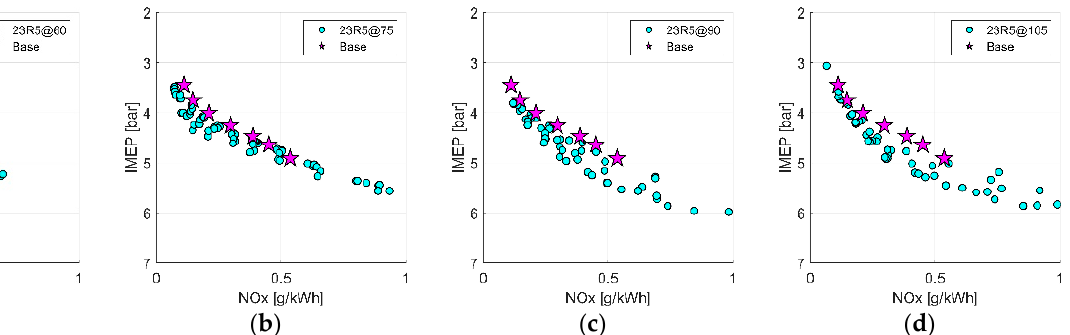
Figure 9. Comparison at PL between the standard bowl (purple stars) and the 23R5 bowl (cyan circles) in terms of varying the tilt angle, depth and SOI. Tilt: 60 deg ( a ); 75 deg ( b ); 90 deg ( c ); 105 deg ( d ).